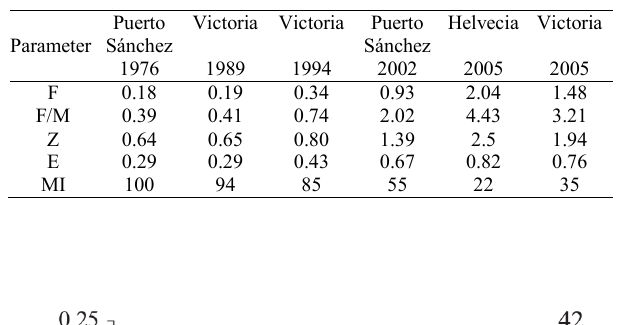
Fig. 6. Sábalo fishery status according to spawning potential ratio (SPR) and fishing mortality (F) variability across